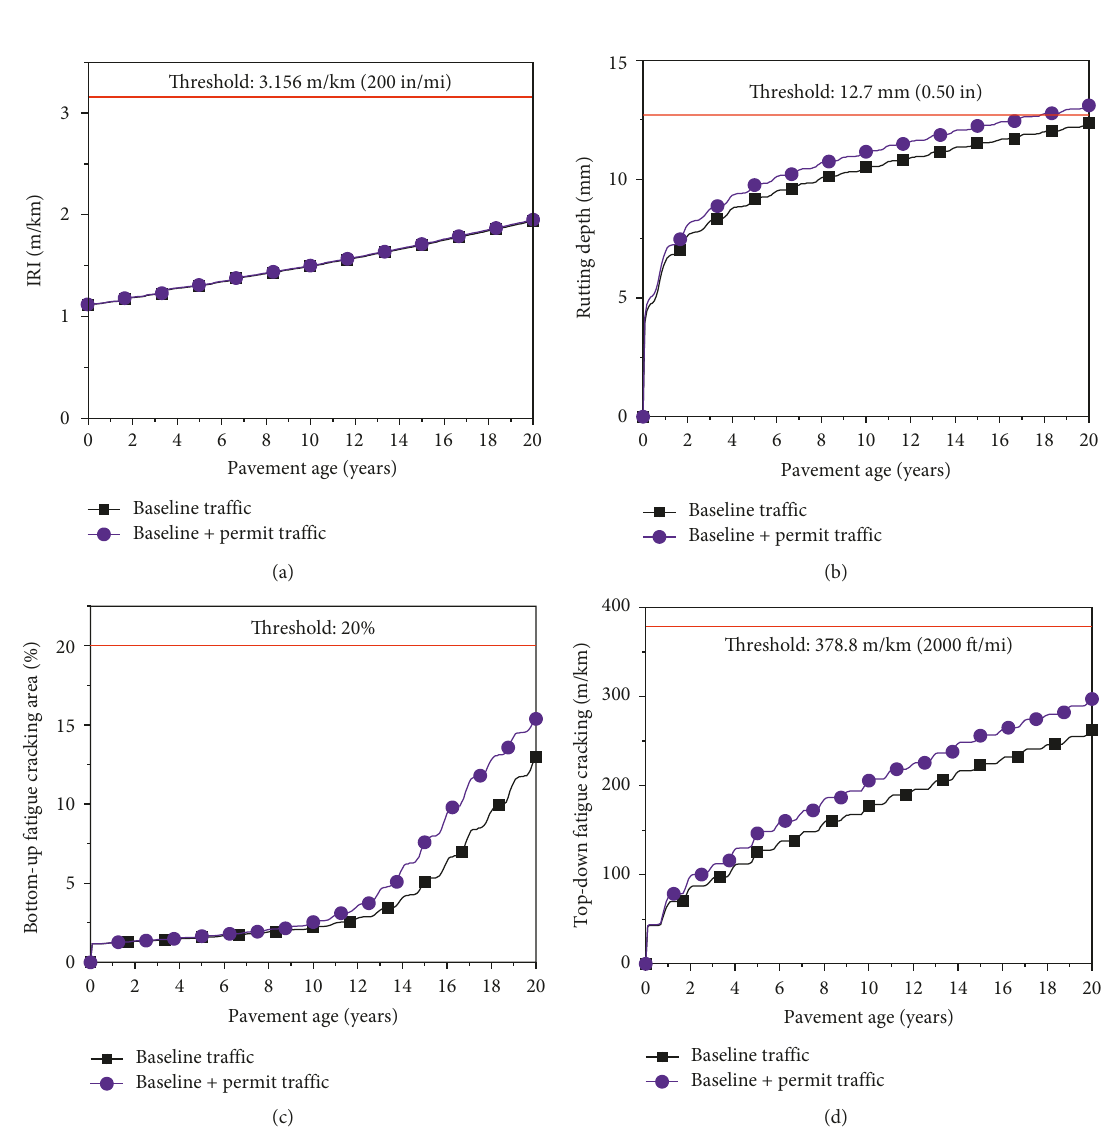
Figure 7: Detailed AASHTOWare Pavement ME distress predictions for STH 140 under baseline traffic loading versus baseline-plus-OW- vehicles. (a) Predicted IRI, (b) predicted total permanent deformation, (c) predicted bottom-up cracking, and (d) predicted top-down